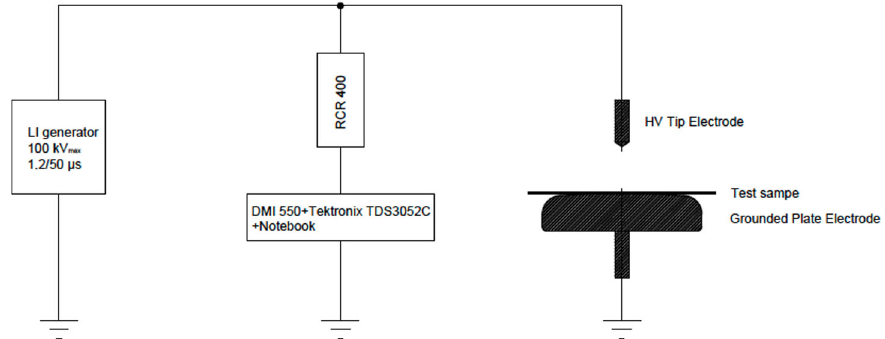
Figure 1. Set up configuration.